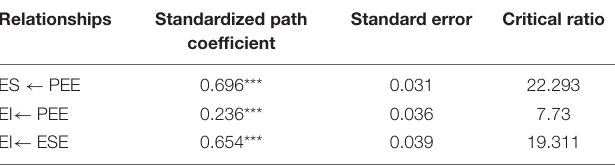
TABLE 5 | Coefficients of the Model Path Analysis. Relationships Standardized path coefficient